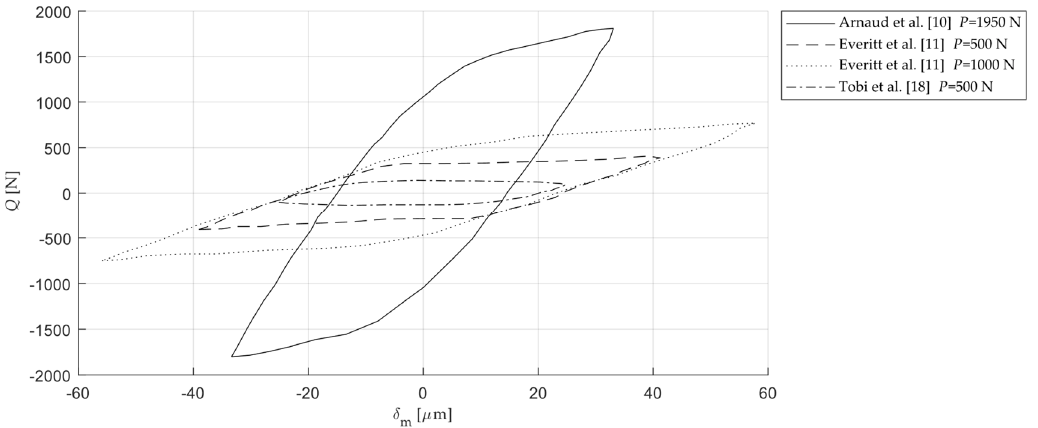
Figure 4. Frictional hysteresis loops in fretting wear tests of different works found in the literature Frictional hysteresis loops in fretting wear tests of di ff erent works found in the [10,11,18] (reproduced with permission of Elsevier). literature [10,11,18] (reproduced with permission of